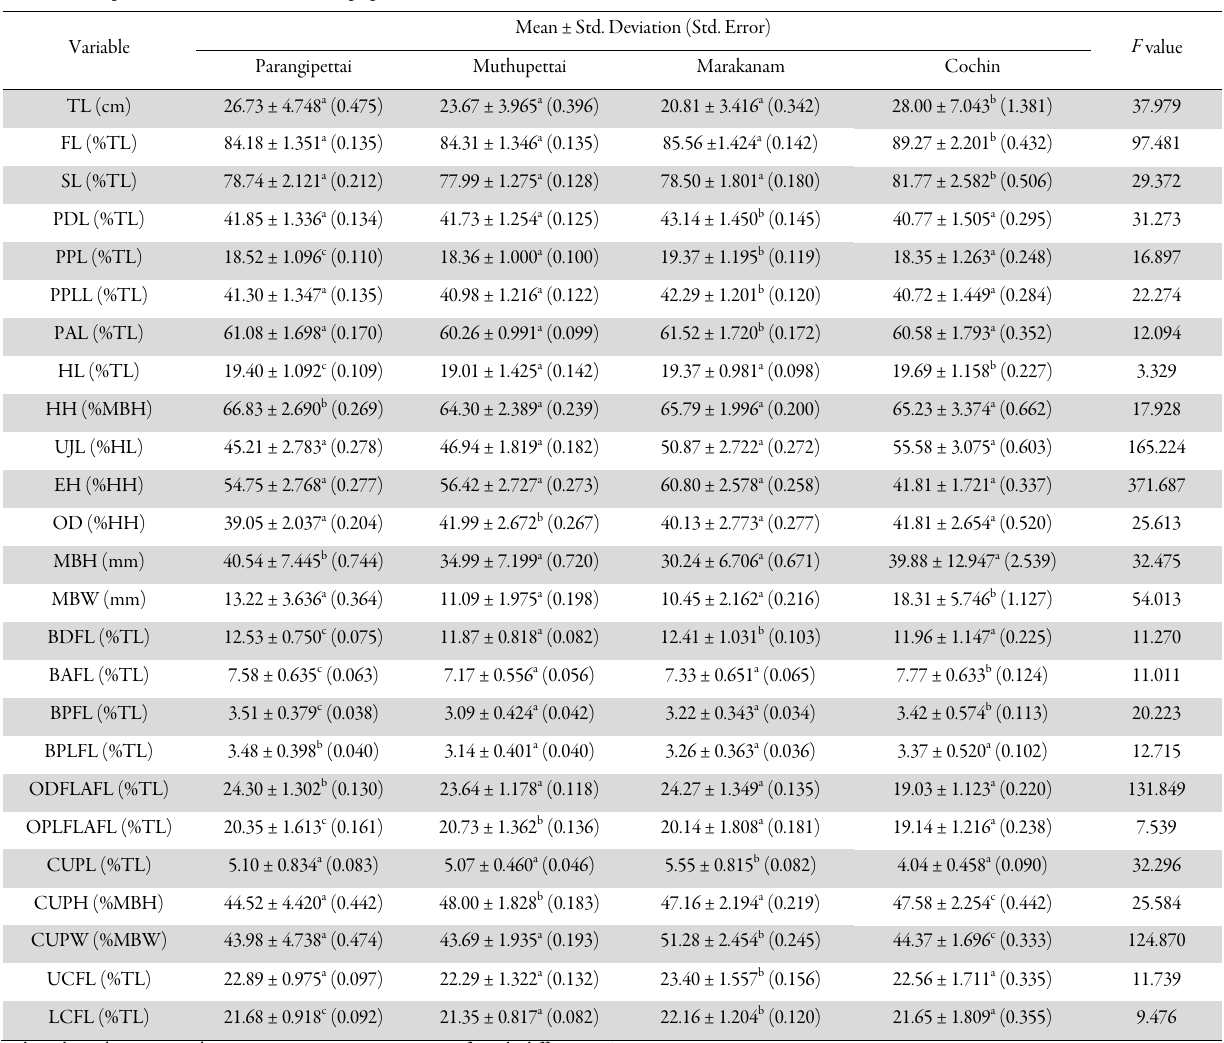
Mean ± Std. Deviation (Std. Error)